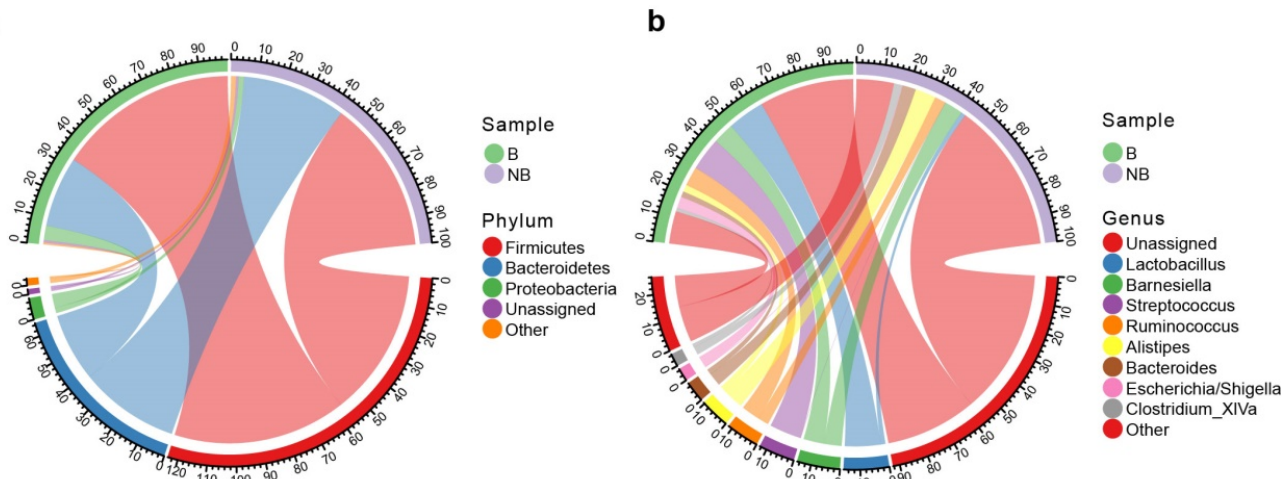
5 of 13 Figure 1. Beta diversity of the gut microbiota in the wild ground squirrel. Principal coordinate